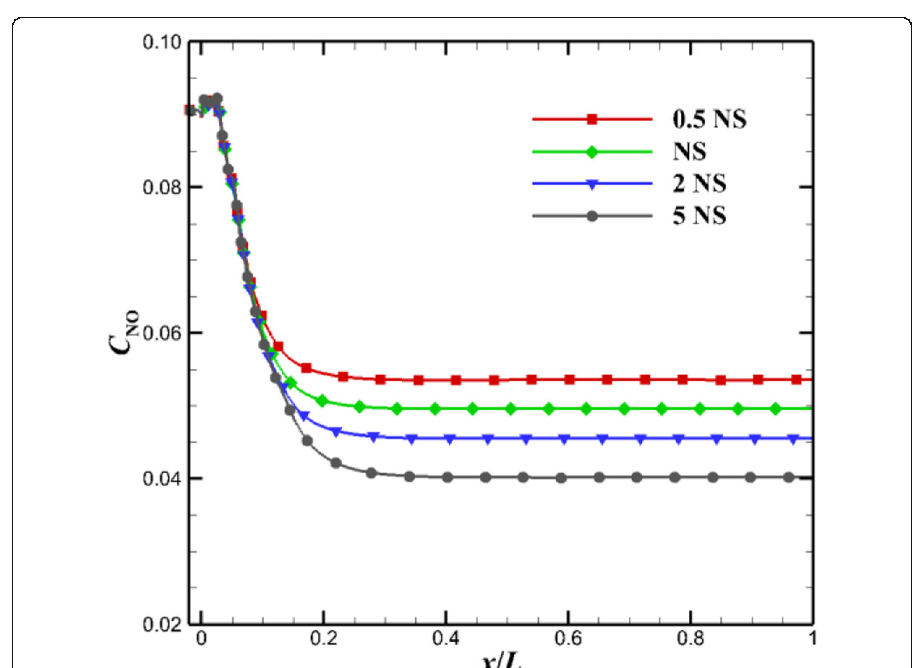
Fig. 15 Comparison of the centerline Mach number distribution based on the HEG nozzle